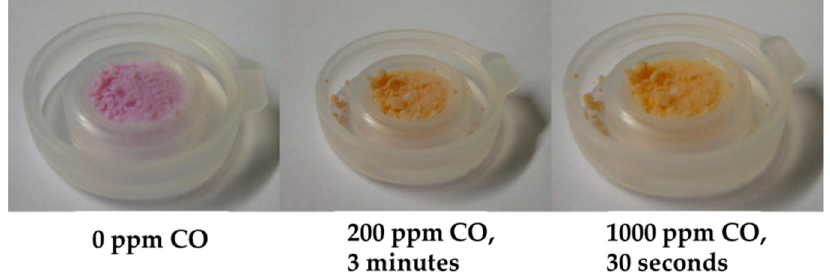
Figure 8. Color change of 1 ∙ (A) 2 adsorbed on silica gel before (left) and after exposure to 50–1000 ppm CO in synthetic air at 50% r.H. Each picture was taken after 30 s of CO exposure. After CO exposure, the color change is reversible, and the silica reaches its original color again.